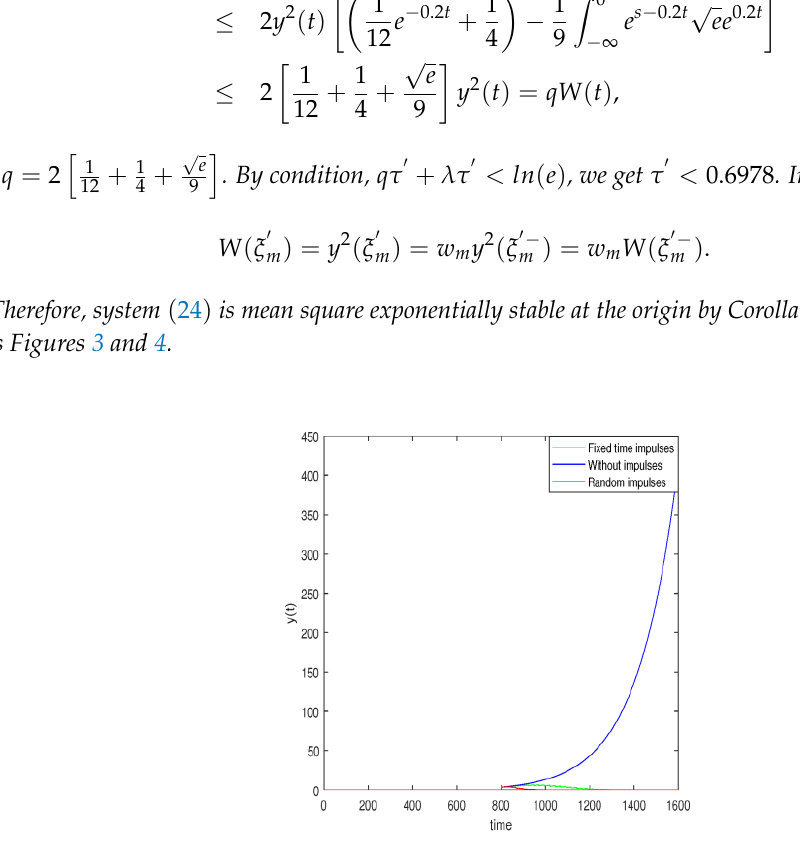
Figure 1. Shows that fixed impulsive effects, random impulsive effects and without impulsive effects of system ( 23 ) .